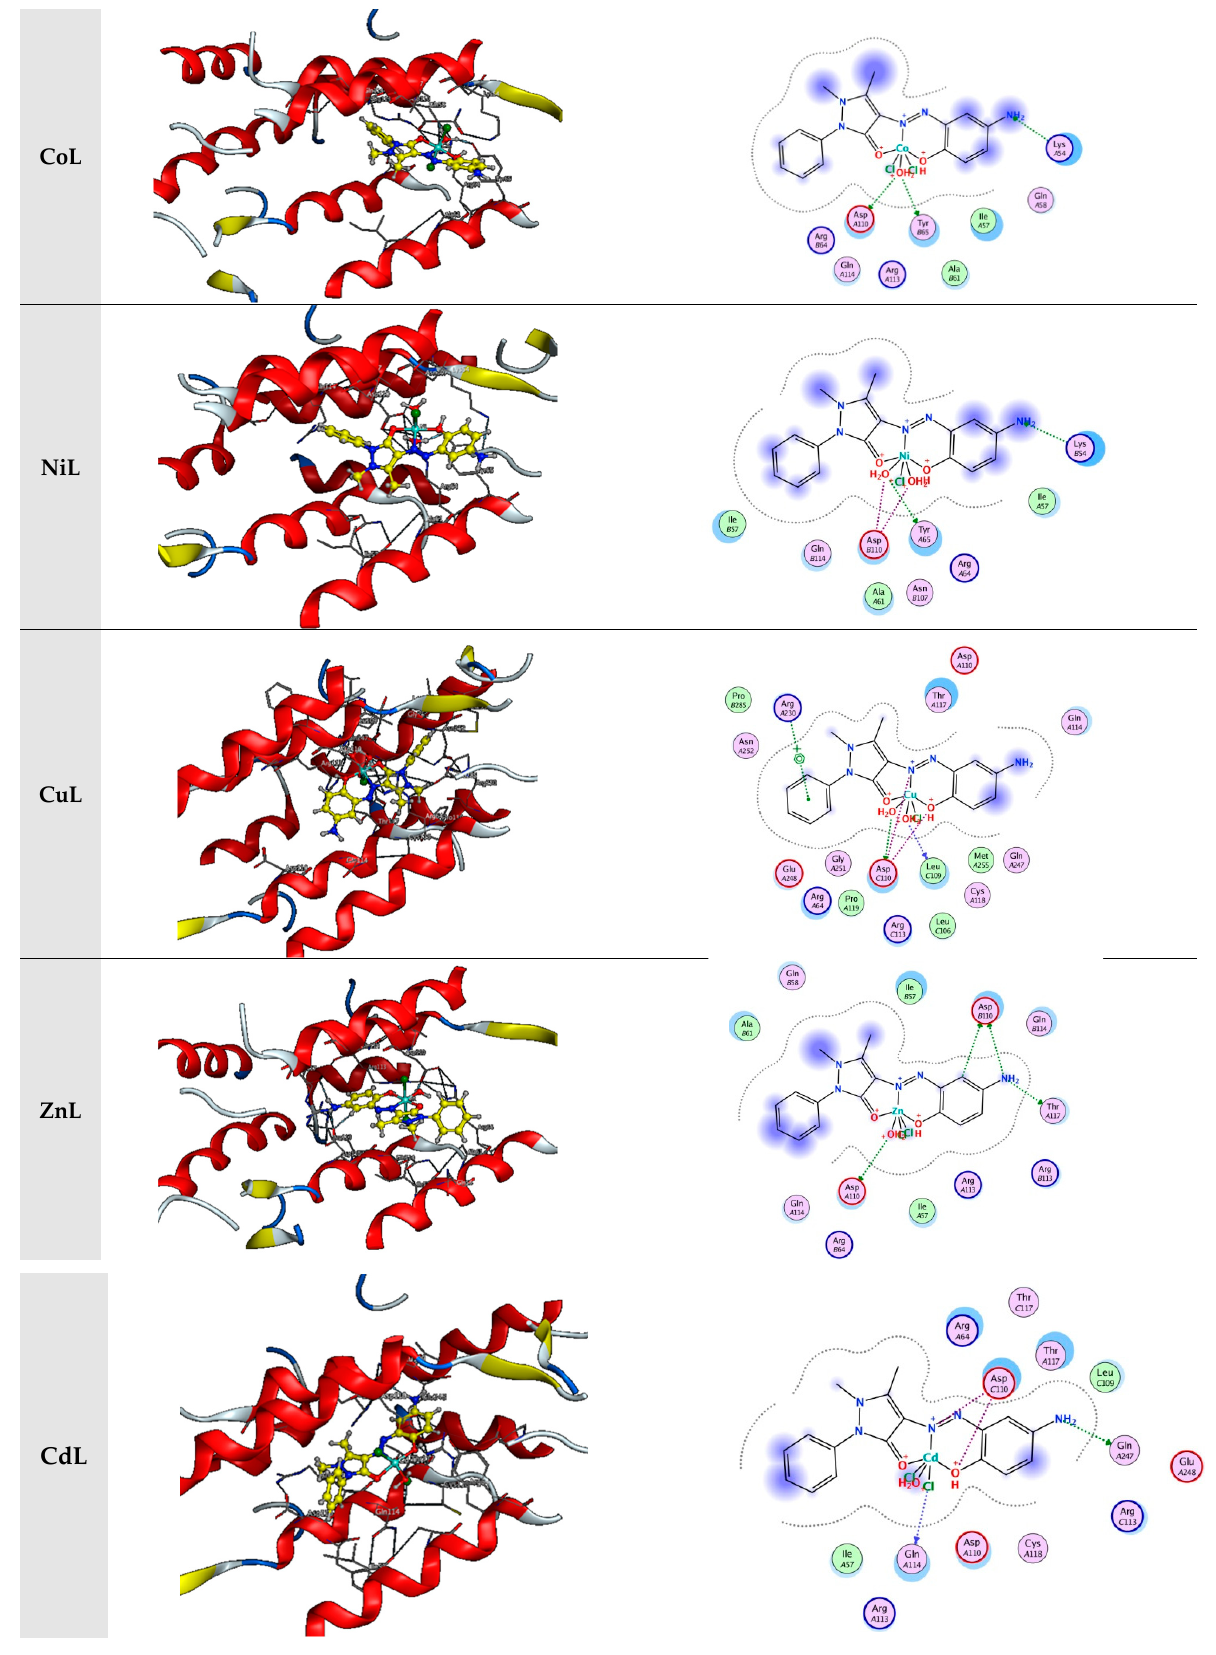
Figure 8. Interaction between the active site of 3t88 with synthesized complexes. Table 2. Docking score obtained and corresponding interaction type.